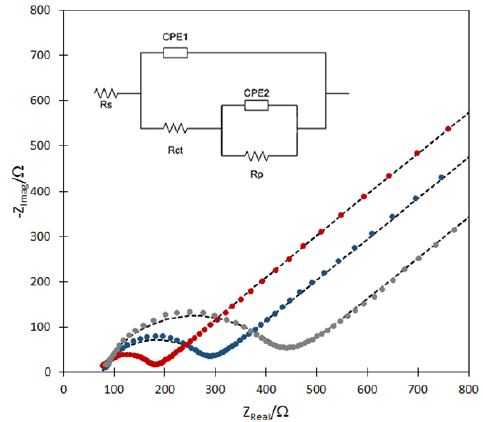
Figure 6. EIS Nyquist spectra of GC (blue), GC/TMPyP (red) and GC/TMPyP/GSH-CdTeQD (gray) electrodes. The segmented line curves illustrate the LEVM fit to the equivalent circuit (insert) used to evaluate the R CT of the K 4 Fe(CN) 6 /K₃Fe(CN)₆ redox reaction in each